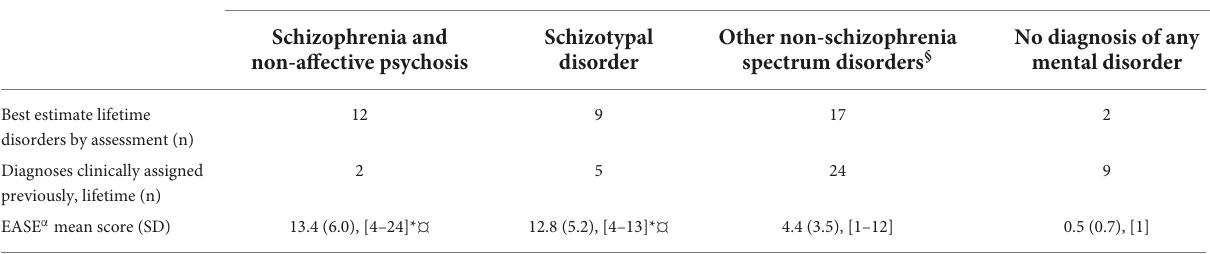
TABLE 1 Distribution among the study population of diagnoses allocated by assessment, previous lifetime clinical diagnoses, and EASE